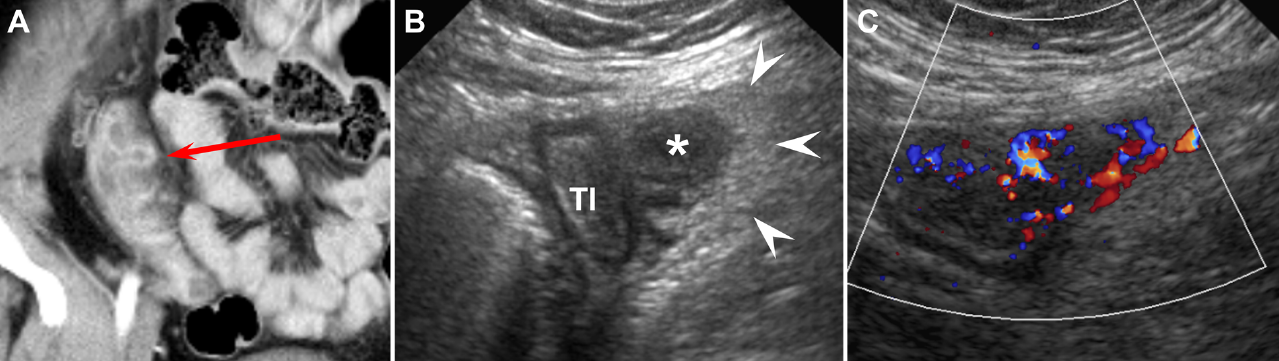
Figure 1. Forty-eight-year-old female (patient #8) with acute ileal diverticulitis. ( A ) Coronal refor- matted enhanced CT scan reveals an outpouching diverticular sac (red arrow) connecting to